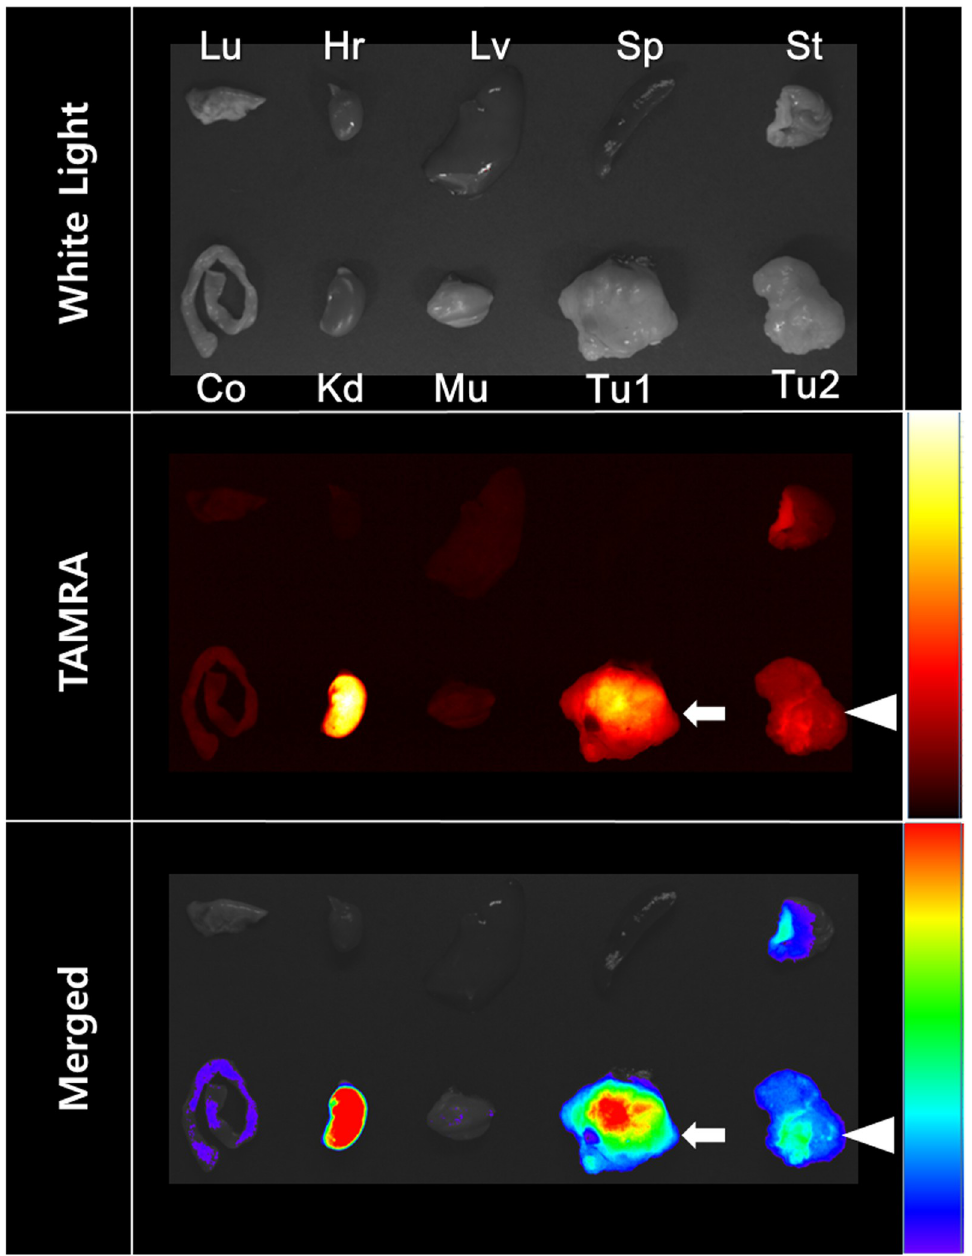
Fig 5. On ex vivo fluorescent images of excised organs, NCI-H460 tumors showed significantly higher fluorescent activity of Tc-99m SYPIPDT-ECG-TAMRA (arrows) than SW620 tumors (arrow heads). (Lu, lung; Hr, heart; Lv, liver; Sp, spleen; St, stomach; Co, colon; Kd, kidney; Mu, muscle; Tu1, NCI-H460 tumor; Tu2, SW620 tumor). processes at the cellular or subcellular level [17]. Several imaging modalities including PET, SPECT, and MR have been introduced to evaluate EGFR expression [17]. Non-invasive molec- ular imaging agents, such as anti-EGFR monoclonal antibodies conjugated MR constrast, Tc- 99m 8B6 Nanobody, F-18 Affibody protein, C-11 erlotinib, Lu-177 nimotuzumab, and C-11 4-N-(3-bromoanilino)-6, 7-dimethoxyquinazoline, have been developed for evaluating EGFR status of tumor [6–10].